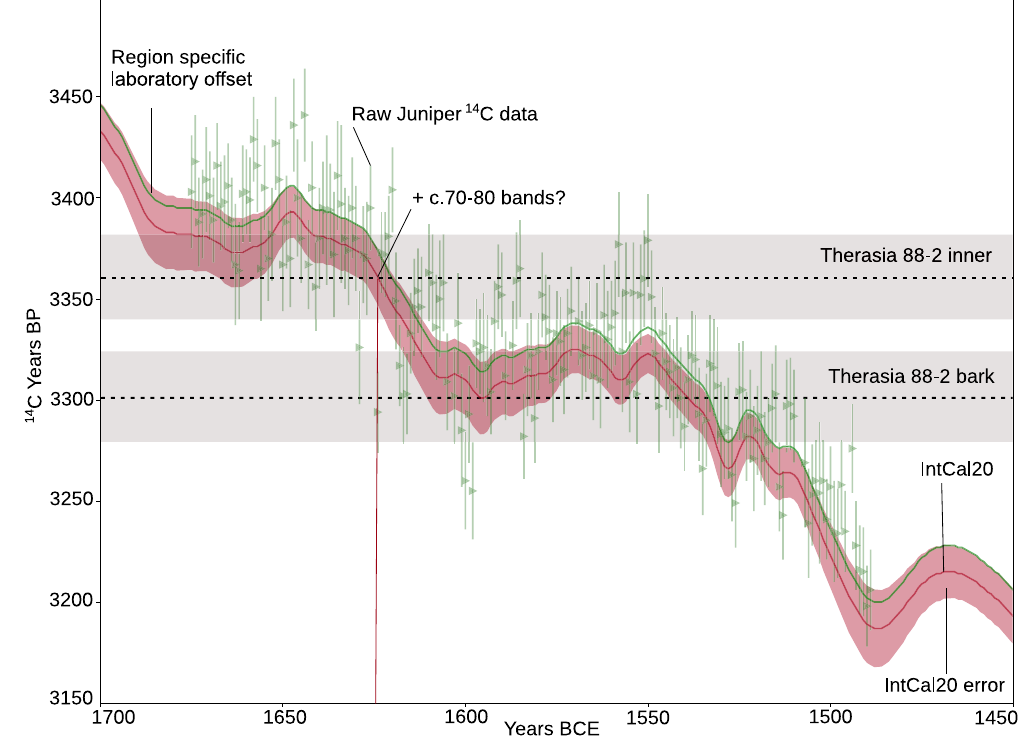
Figure 4. Radiocarbon measurements from single years of a Mediterranean juniper tree (green) run at the same laboratory / same time as the Therasia samples, relative to IntCal20 16 . The offset towards older ages reflects the difference between data from a single region / single laboratory and the IntCal20 16 mean. To illustrate uncertainties associated with calibration, the inner-most and bark results from stem 88-2 are shown (horizontal dotted line, grey error) intersecting with two radiocarbon plateaus in the time period. If considered to represent annual growth, band counting of sample 88-2, combined with the most likely point of intersection for the inner- most determination with intCal20 16 , indicates a death date towards the middle of the 16th century BCE, but clear uncertainties